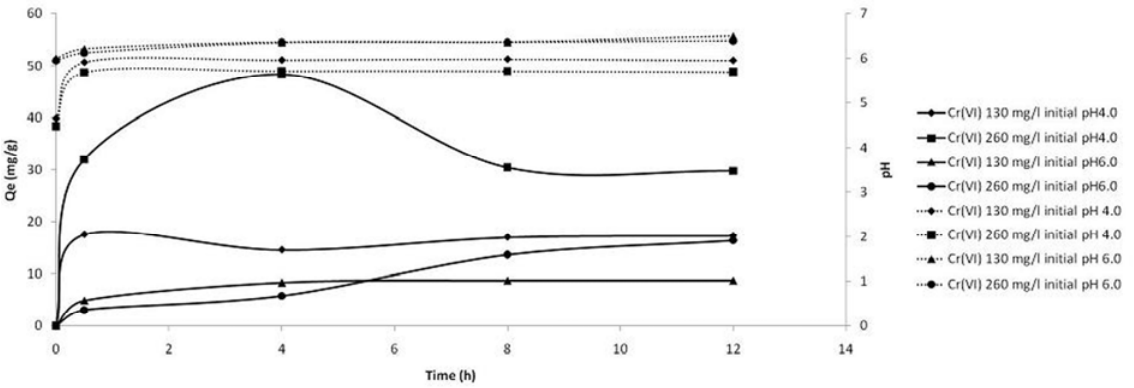
Figure 4. Adsorption kinetic curves for Cr(VI) on chitosan/zeolite film (full line) and evaluation of pH during assays (dotted